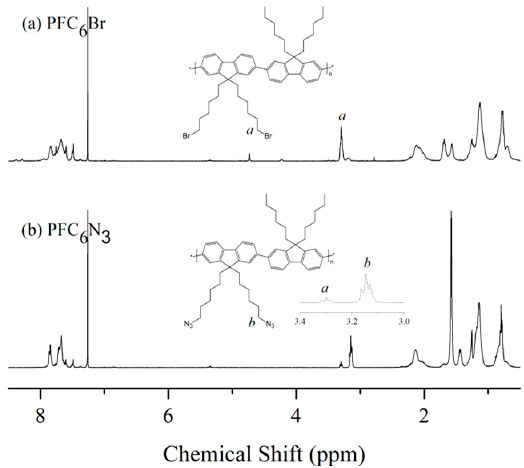
Figure 5. 1 H NMR spectra of ( a ) PFC6Br and ( b ) PFC6N 3 in CDCl 3 .